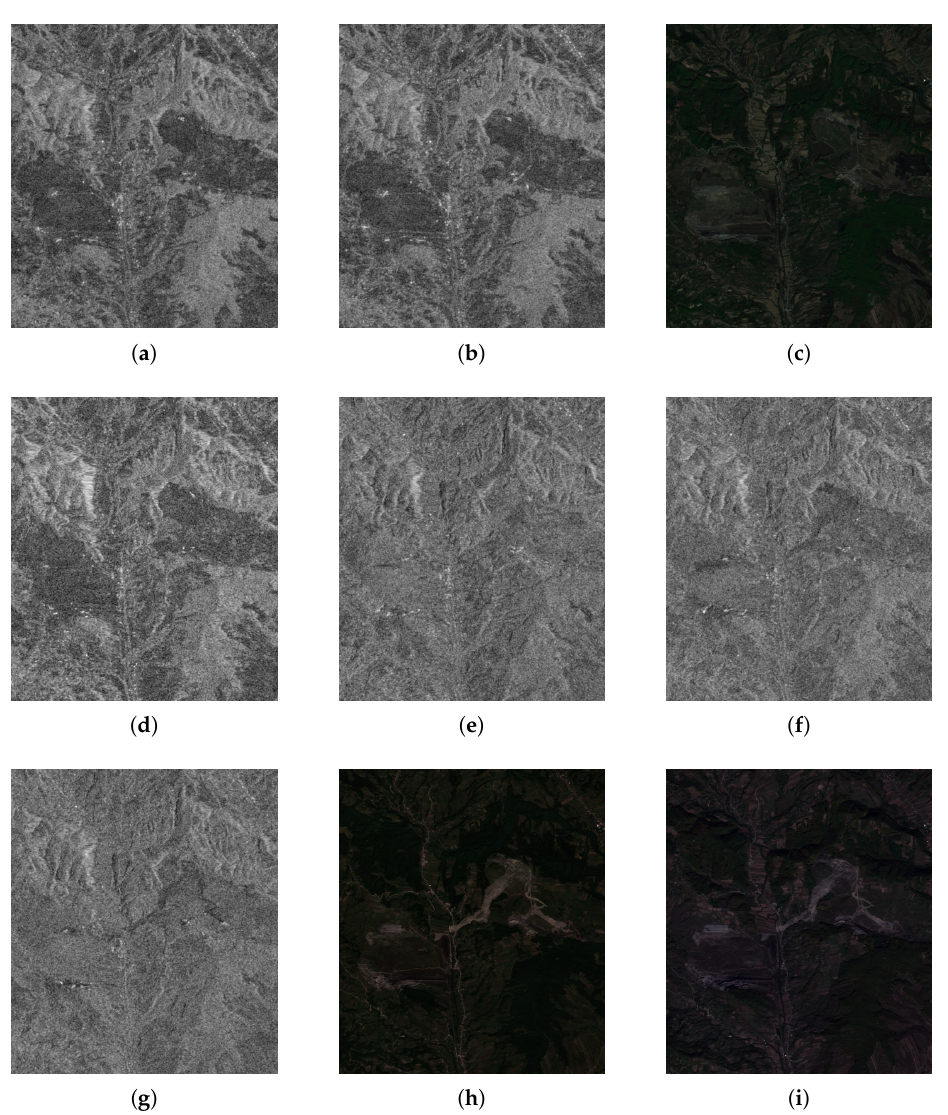
Figure 3. Mixed Sentinel-1 and Sentinel-2 SITS for landslide detection: ( a ) 18 December 2016 (Sentinel-1), ( b ) 30 December 2016 (Sentinel-1), ( c ) 9 April 2017 (Sentinel-2), ( d ) 10 April 2017 (Sentinel-1), ( e ) 11 May 2017 (Sentinel-1), ( f ) 16 June 2017 (Sentinel-1), ( g ) 22 July 2017 (Sentinel-1), ( h ) 27 August 2017 (Sentinel-2), ( i ) 16 October 2017 (Sentinel-2). The information for both use-case scenarios is synthesized in Table 1. Table 1. Use-case